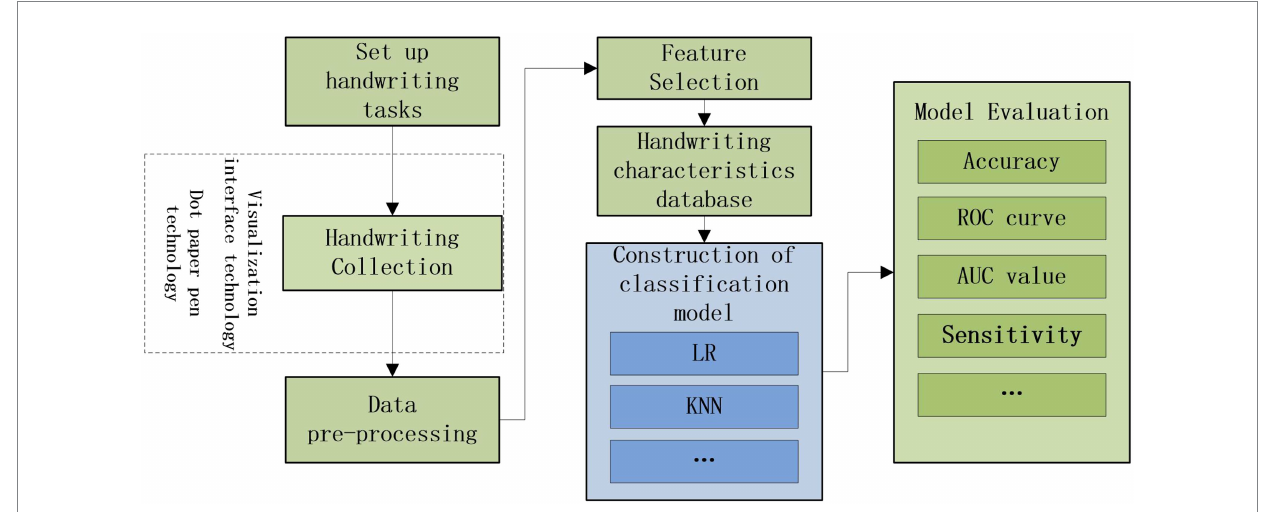
FIGURE 2 Experimental design scheme